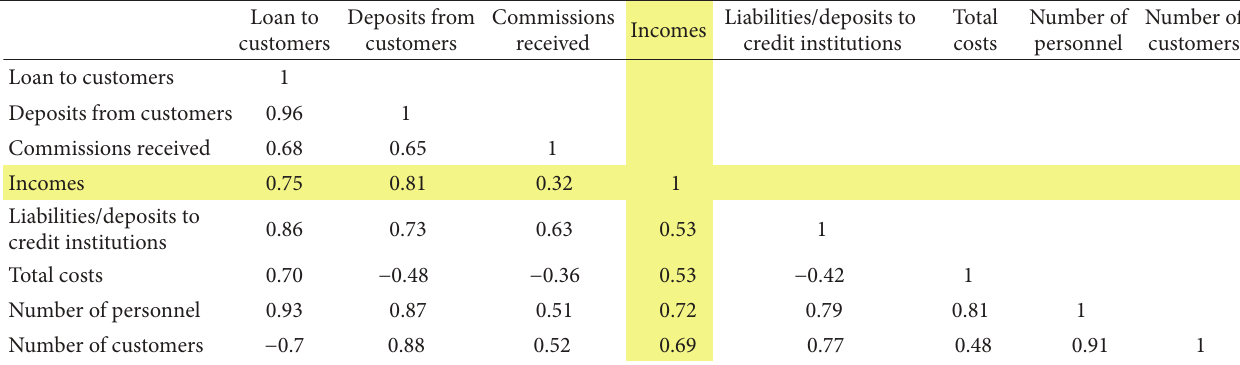
Table 4: Correlation matrix for the variables.